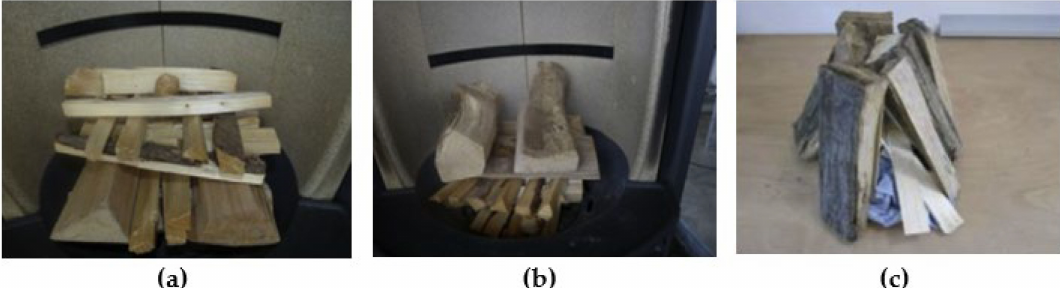
Figure 2. Placement of kindling material and firewood pieces according to top-down ( a ) and bottom- up ( b,c ) ignition techniques. Cross joint placement ( a,b ) and traditional placement like a campfire ( c ) [10,11]. ( a , b ) Reprint with permission from G. Reichert, H. Hartmann, W. Haslinger, H. Oehler,